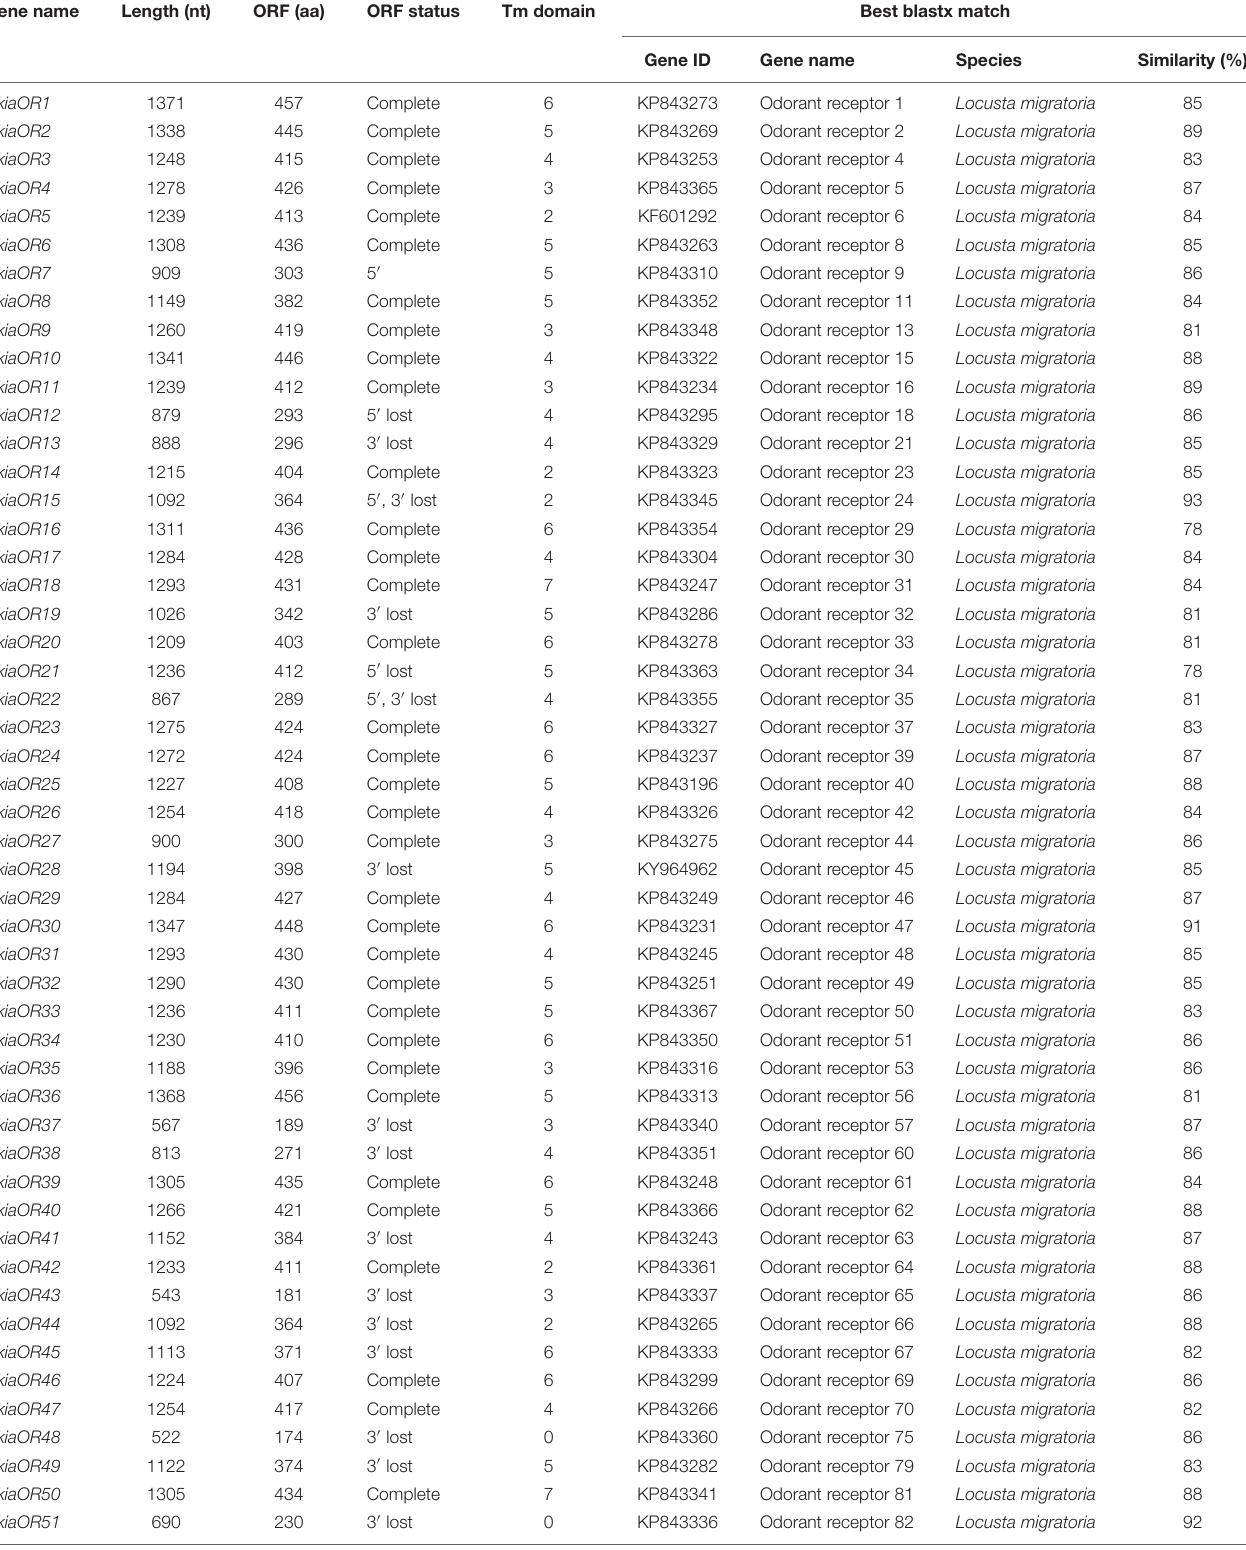
TABLE 1 | Summary of putative odorant receptors (ORs) identified in C. kiangsu